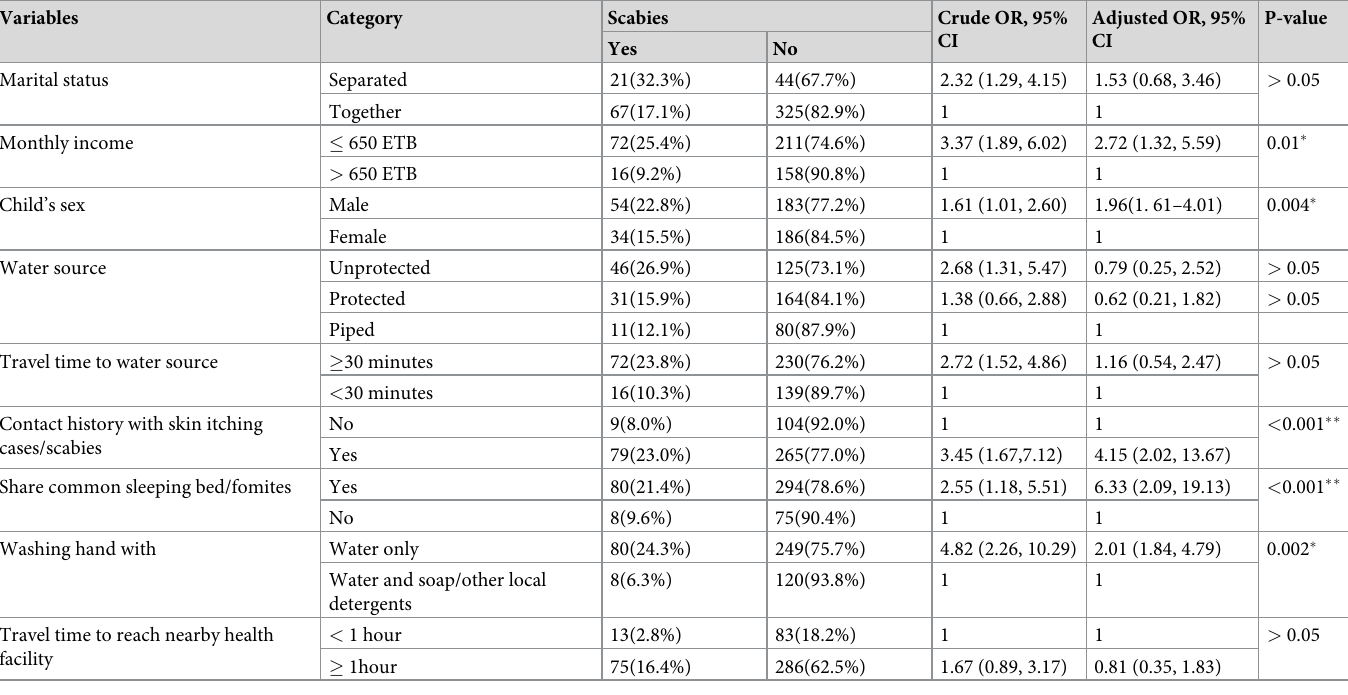
Table 6. Multivariate analysis of factors associated with scabies among children aged 5–14 years in Meta Robi District, Ethiopia, 2020.